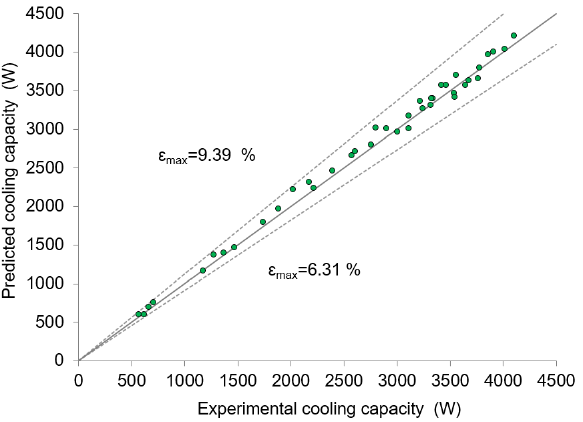
Figure 14. The deviation between calculated and experimental values of the cooling capacity.